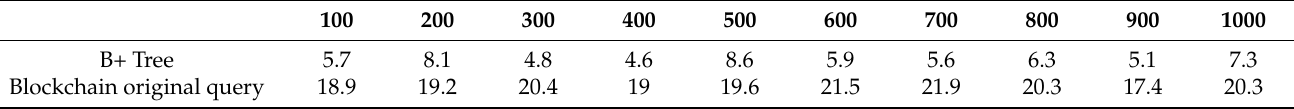
Table 6. Query time of different numbers of blockchain